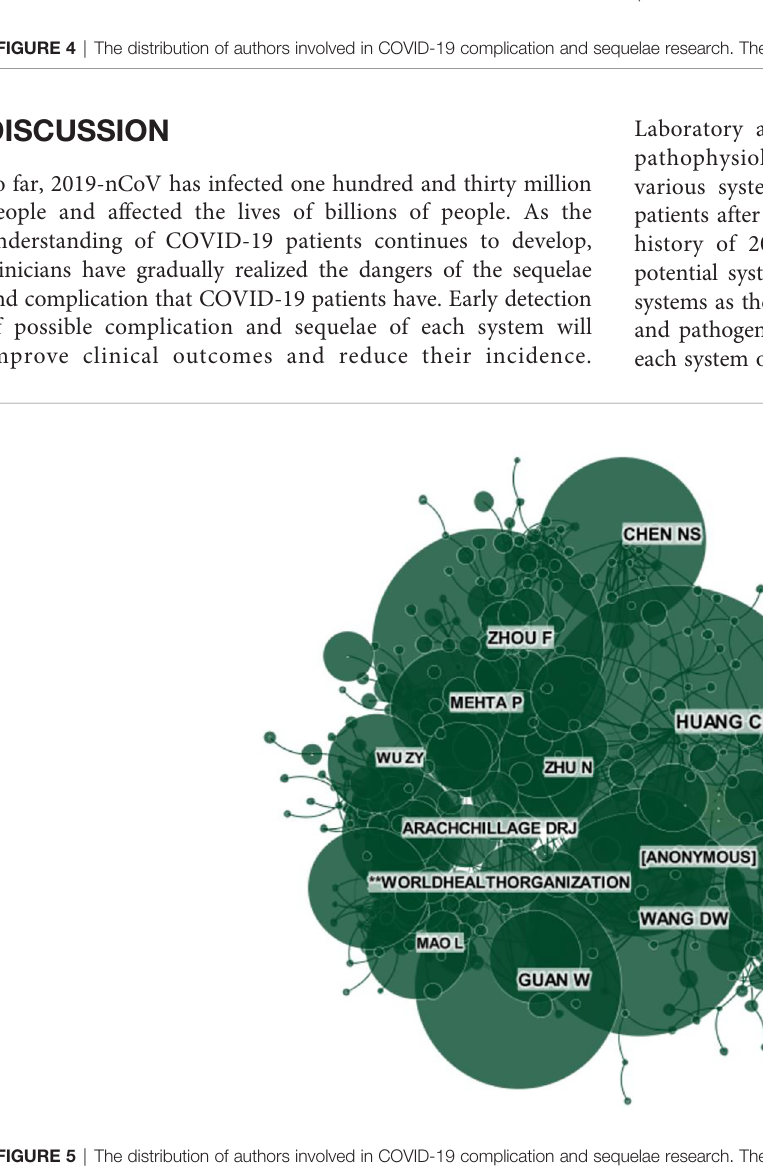
FIGURE 5 | The distribution of authors involved in COVID-19 complication and sequelae research. The network map of co-cited